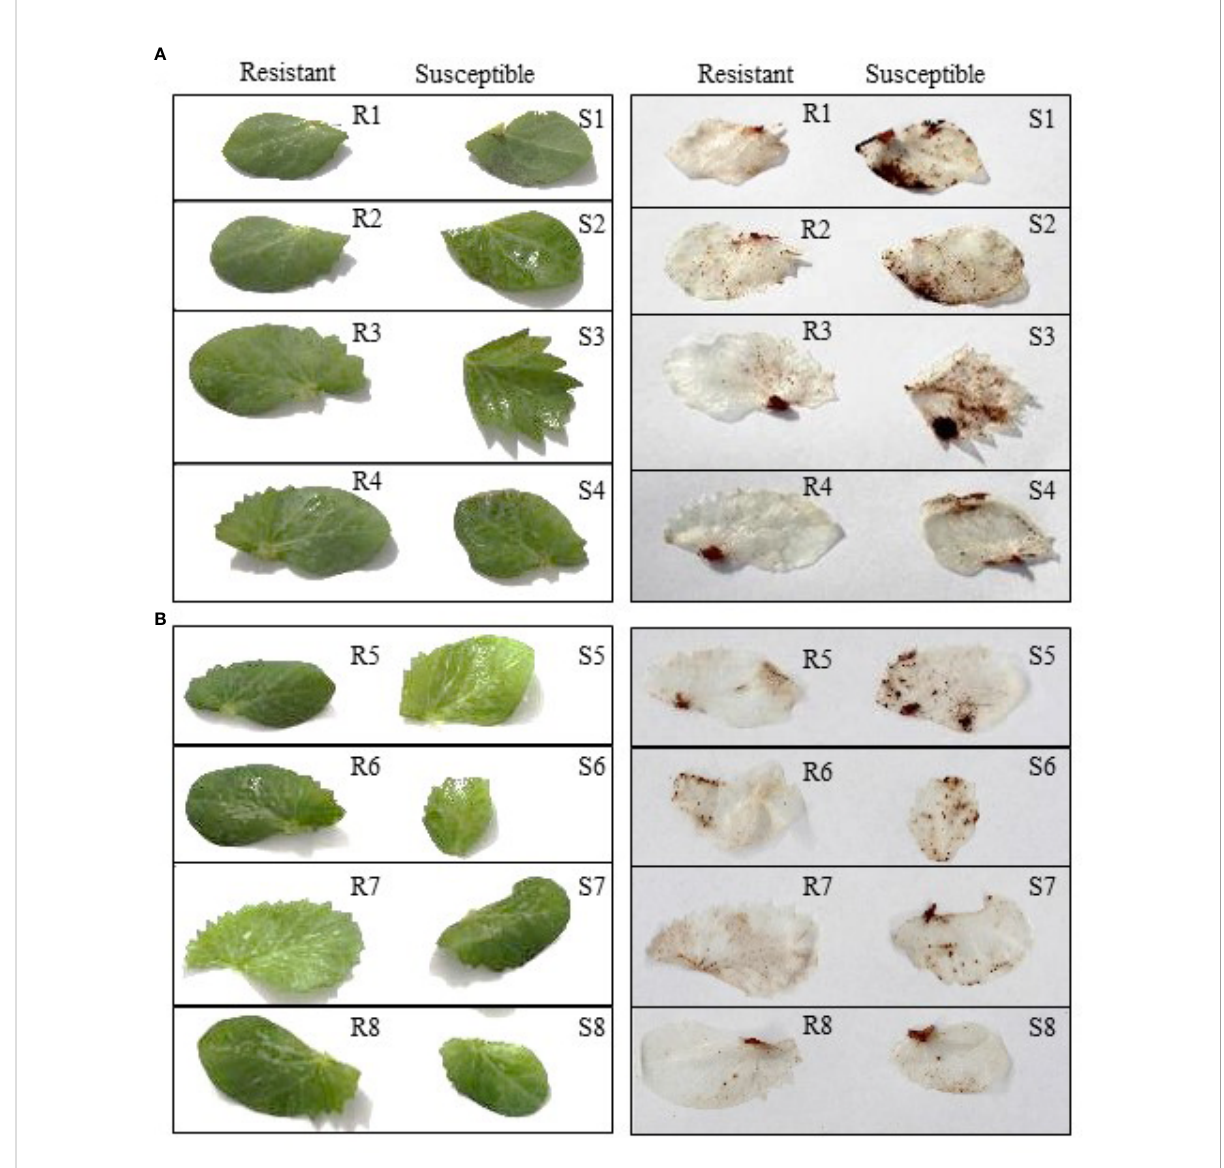
FIGURE 2 Detection of hydrogen peroxide through di-amino benzidine (DAB) staining in fi eld pea leaves, visualized at 96 hours post inoculation with Peyronellaea pinodes (A) and Didymella pinodella (B) . R1, PBA Wharton; R2, 11HP302-12HO-1; R3, 05H161-06HOS2005-BOG09-2; R4 09HP216-10HO2-3; S1, OZP1604; S2, 11HP160-12HO-1; S3, PBA TWILIGHT; S4, 10HP249-11HO-7; R1-4 partially resistant and S1-4, susceptible to P. pinodes. R5, 10HP249-11HO-7; R6, PBA WHARTON; R7, PBA TWILIGHT; R8, 11HP420-12HO-13; S5, WAPEA2211; S6, OZP1604; S7, PBA OURA; S8, 09HP216-10HO2-3; R5-8 partially resistant and S5-8 susceptible to D. pinodella